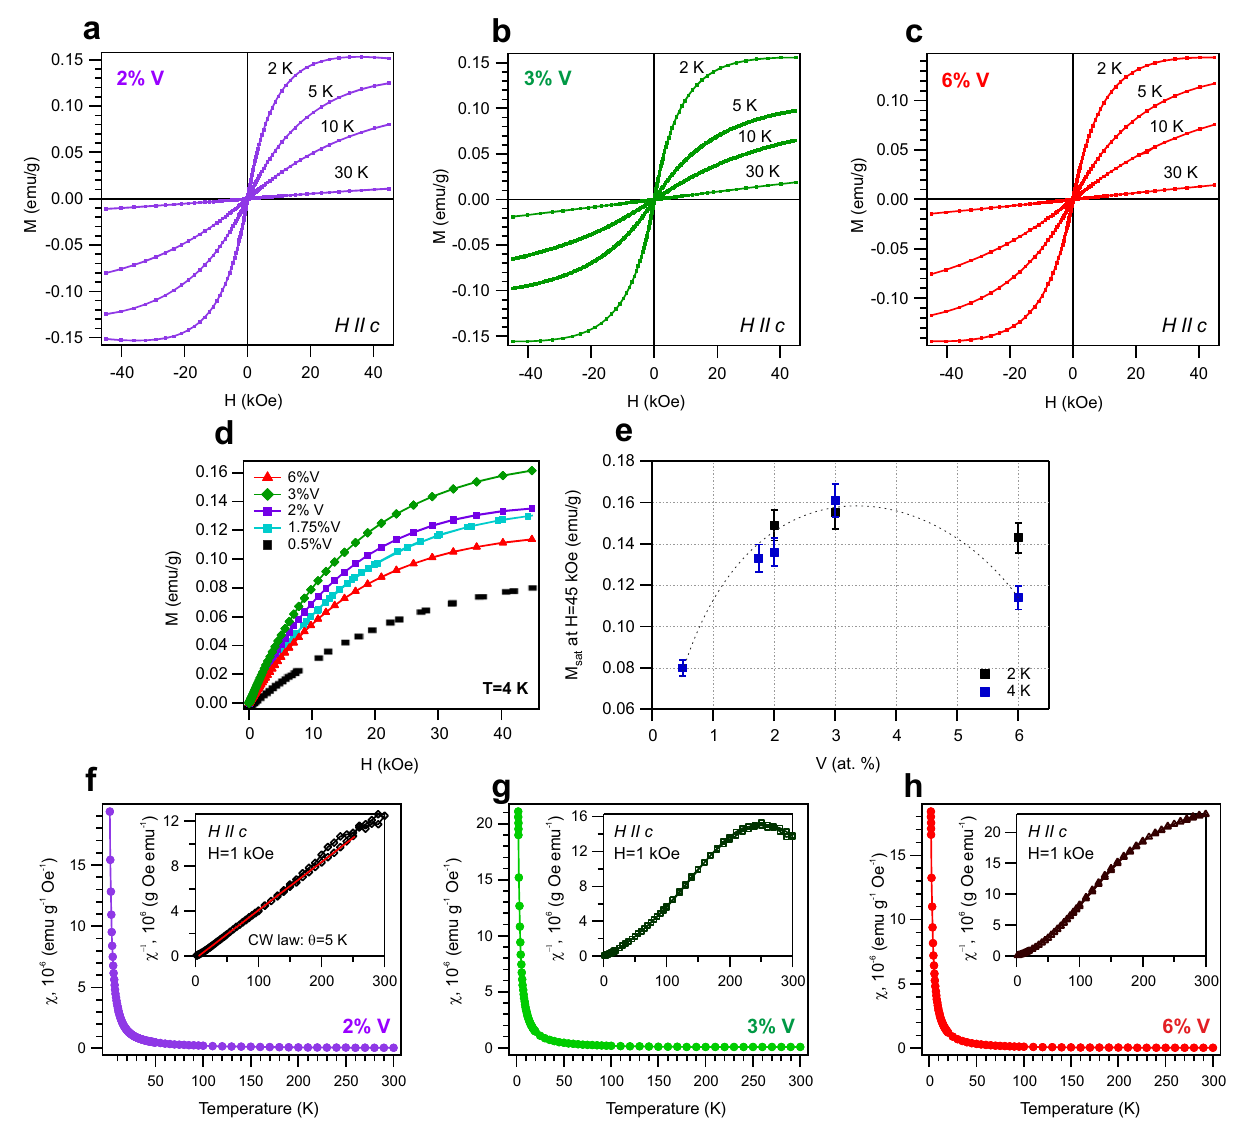
Figure 3. Comparative magnetization measurements using SQUID magnetometry. ( a – c ) Isothermal magnetization curves M(H) at several temperatures for 2%V, 3%V and 6%V-doped BiTeI, respectively. The external magnetic field was applied perpendicular to the surface plane, i.e. along c -axis. ( d ) Comparative analysis of the magnetization curves M(H) measured for 0.5%V, 1.75%V, 2%V, 3%V and 6%V-doped BiTeI at 4 K. ( e ) Dependence of the maximum M value at high magnetic field (saturation magnetization at H = 45 kOe) vs V-concentration. The dash line for the 4 K measurements is a guide for the eye. ( f – h ) Zero-field cooled (ZFC) 1 and field cooled (FC) magnetic susceptibility curves ( χ ) and inverse magnetic susceptibility ( χ − ) as a function of temperature for V-concentrations of 2%, 3% and 6% with 1 kOe field applied perpendicular to the surface energy gap at T = 0 K. The estimated values of the KP gap for different V-concentration at T = 0 K and at some different temperatures are shown in Table 1 of Suppl. Mat. The KP gap size dependence at T = 0 K, estimated under the assumption of the surface Curie temperature of about 130 K is shown in Fig. 1d by solid blue line and dots. All estimated temperature-dependent gaps correlate with the experimentally measured ones, including the values measured at temperatures between 1 and 100 K (see Suppl. Figs. 2S–4S, 5S and Fig. 4a). This may indicate the validity of the assumption about the enhanced surface Curie temperature (with the possible realization of spin fluctuations) and the corresponding dependence of the KP gap size on temperature measured by ARPES. Noteworthy, the non-monotonic behaviour of the KP gap as in Fig. 1d,e was previously observed in Ref. 29 for Mn-doped α -GeTe. However, in this paper the gap starts to saturate at larger amount of Mn impurity ( ∼ 10%) and shows no decrease under further Mn concentration rise (at least up to 15%). The saturation in the gap size with a further increase in Mn-concentration was associated in this work with Mn-phase segregation and corresponding antiferromagnetic coupling between neighboring Mn atoms that reduces the average FM moment per Mn atom.